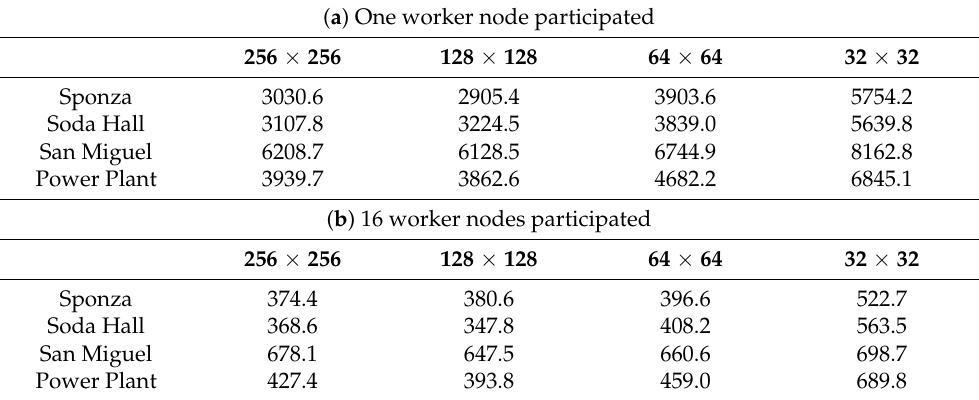
Table 8. Distributed ray tracing times for varying tile sizes. The rendering times for producing a 1024 × 1024 image using tiles of given pixel sizes are reported in milliseconds. In this experiment, the static load balancing scheme was adopted for distributed ray tracing, which outperformed the dynamic load balancing scheme, as will be explained